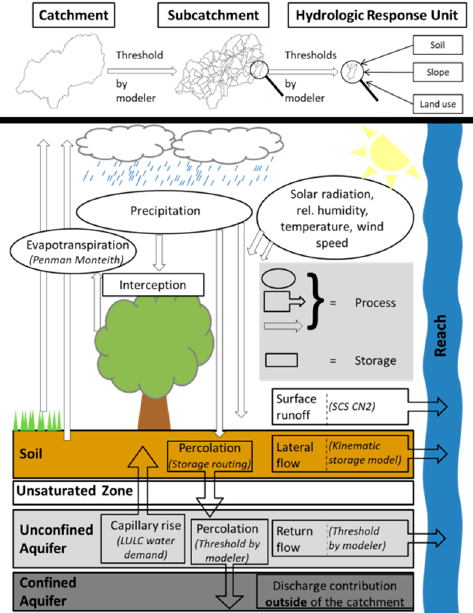
Figure 3. Catchment discretization and schematic overview of processes and storages simulated by the SWAT model. Applied methods to simulate evapotranspiration and water fluxes are shown in parentheses (modified after Neitsch et al. [52]).